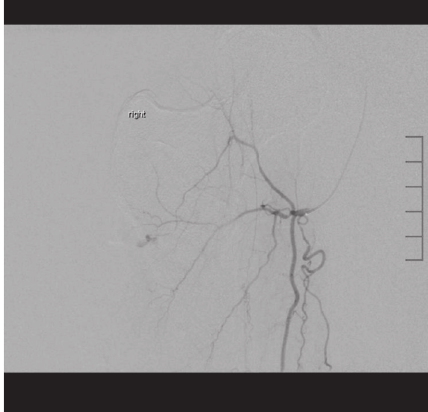
Figure 9: Selective deep femoral branch arteriogram further details the area of active bleeding.